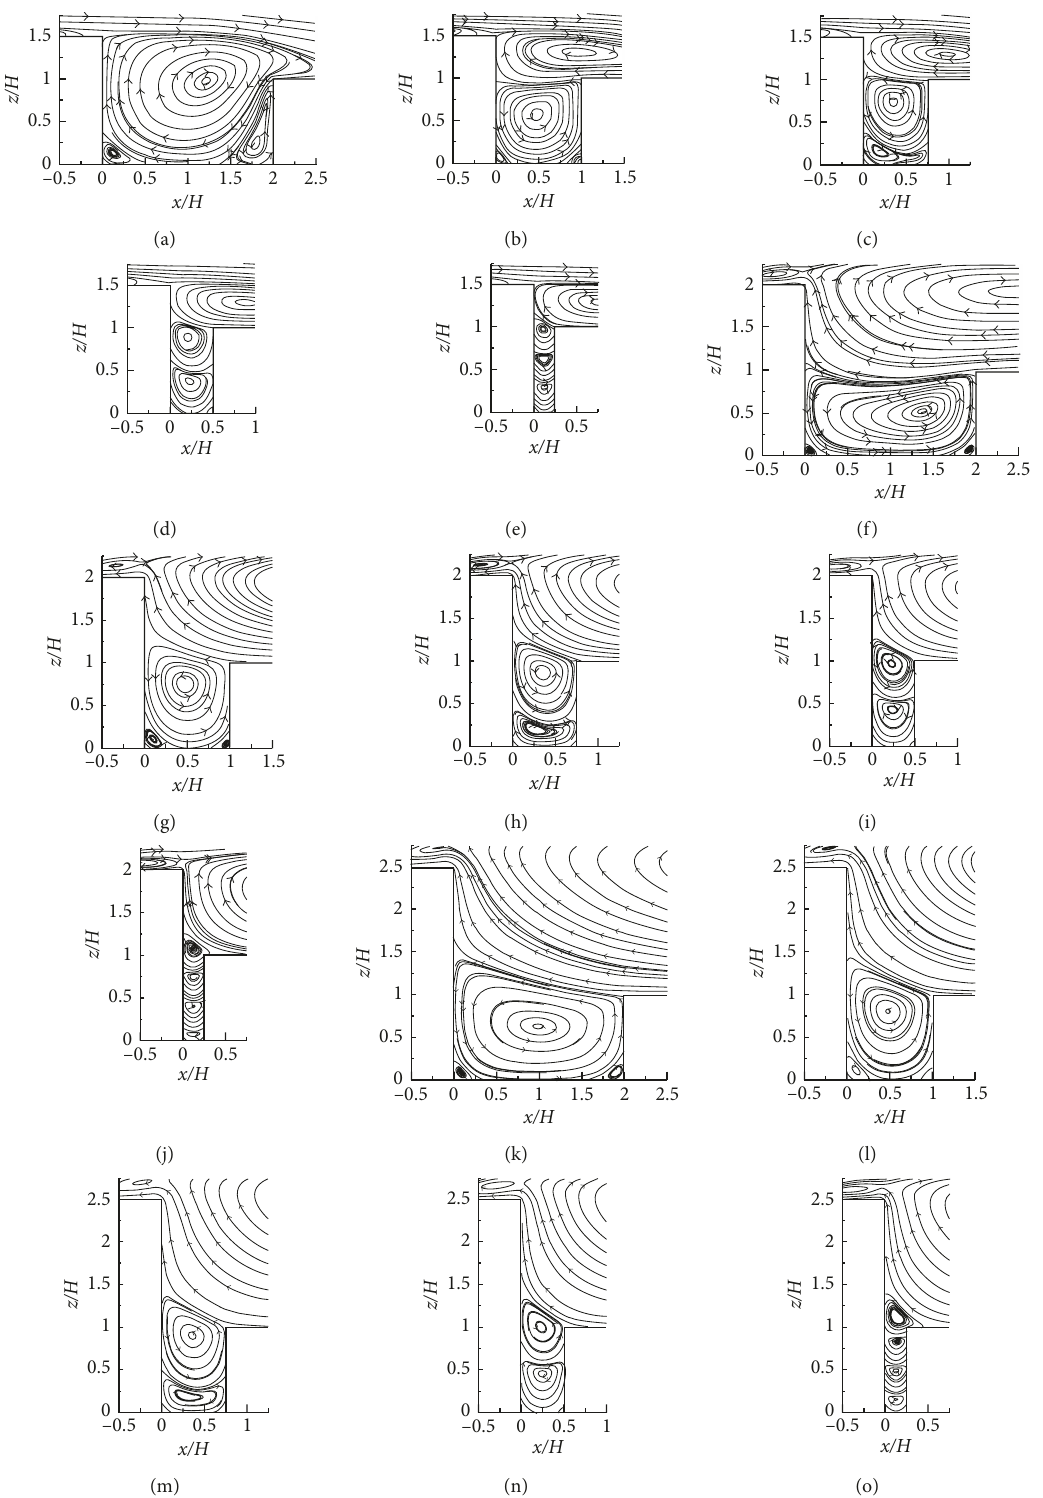
Figure 12: Streamlines of the simulated velocity magnitude V for AR AR 1 with H 2 / H 1 (cid:31) for AR 2 with H 2 / H 1 (cid:31)